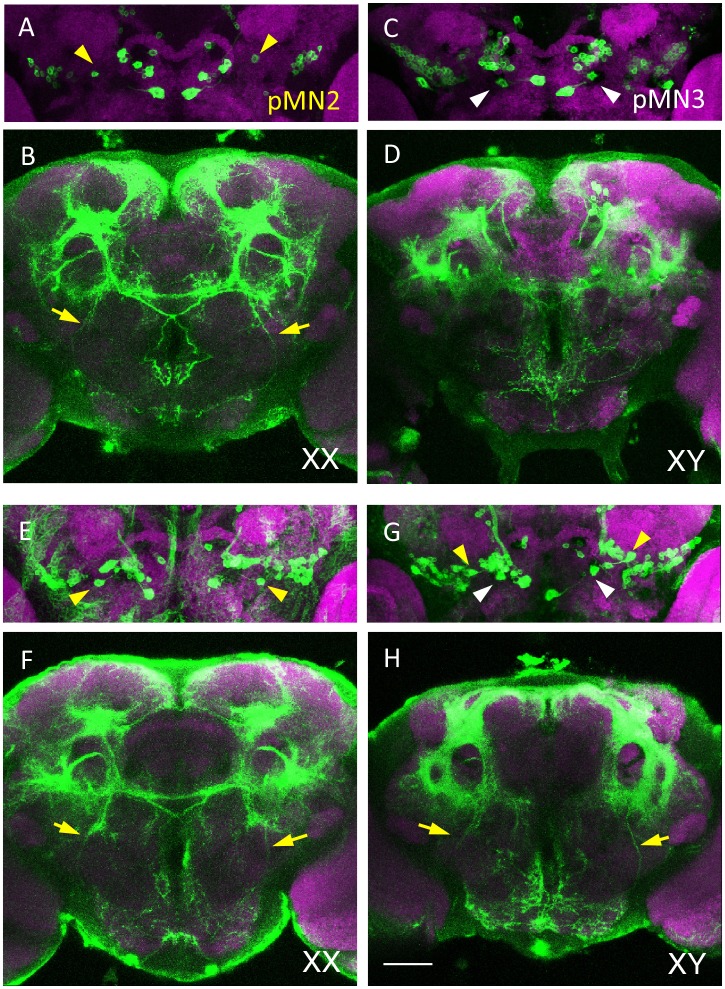

dsx-expressing neurons in dsx mutants.(A, B) A pair of cell bodies of female-specific pMN2 neurons (yellow arrowheads in A) and their neurites (yellow arrows in B) are present in a control XX female of UAS-mCD8::GFP /+; dsx
GAL4
(B)/TM6b. (dsx
GAL4
(B); the GAL4 knock-in null allele of the dsx gene was generated by the Baker group at Janelia Farm Research Campus (Ashburn, VA)). (C, D) A pair of cell bodies of male-specific pMN3 neurons (white arrowheads in C) are present in a wild-type male (XY) of UAS-mCD8::GFP/+; dsx
GAL4
(B)/TM6b. (E, F) In the female (XX) of UAS-mCD8::GFP/+; dsx
GAL4
(B)/dsx
15, the cell bodies of pMN2 neurons and their neurites are observed (yellow arrowheads in E and yellow arrows in F, respectively). (G, H) A pair of cell bodies of pMN2 (yellow arrowheads in G) and its neurites (yellow arrows in H) are seen ectopically in addition to male-specific pMN3 (white arrowheads in G) in the brain of a male fly (XY) with the genotype UAS-mCD8::GFP/+; dsx
GAL4
(B)/dsx
15. Brains were doubly stained with anti-GFP (green) and nc82 mAb (magenta). The scale bar represents 50 μm.